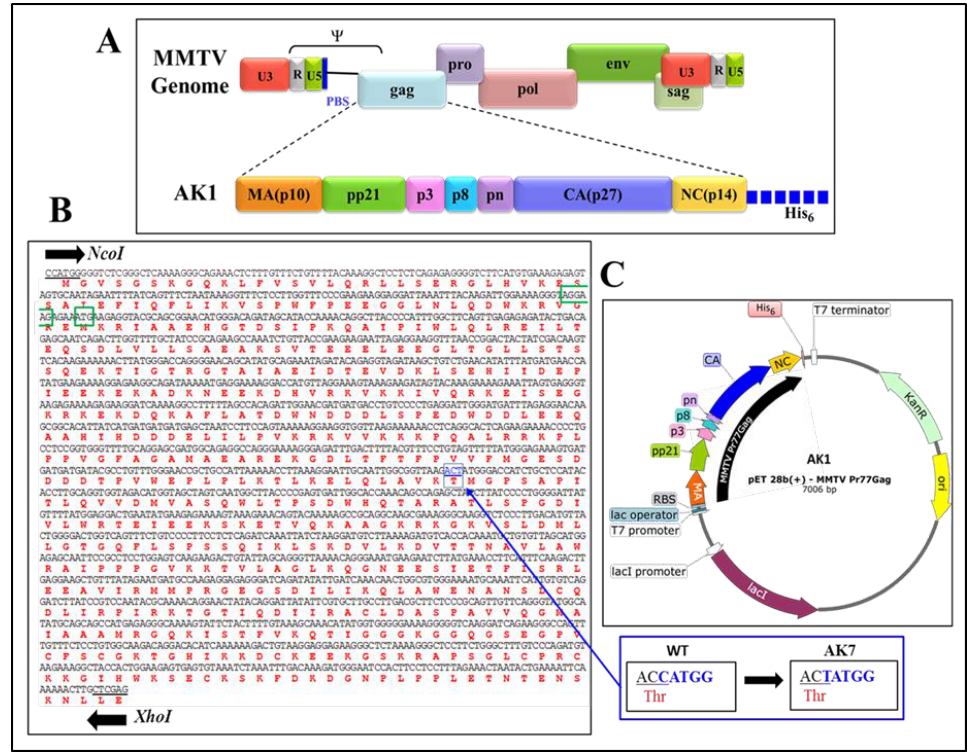
Figure 1. Construction of the recombinant full-length Pr77 Gag bacterial expression vector. ( A ) Domain organization of the mouse mammary tumor virus (MMTV) Gag precursor with His 6 -tag; ( B ) Nucleic acid and amino acid sequences of full-length MMTV gag gene. An internal Nco I site (boxed in blue color) was removed by introducing a silent mutation (shown in the inset) that preserved the threonine (Thr) amino acid. The Shine-Dalgarno-like sequence and second in-frame ATG are highlighted by green color; ( C ) Schematic representation of bacterial expression plasmid AK1 containing full-length MMTV Pr77 Gag gene cloned into the Nco I and Xho I sites of the pET28b(+) vector.